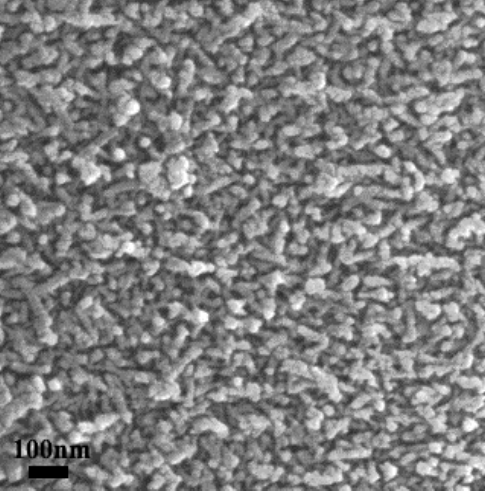
Figure 7. SEM image of the Pt 0.3 /CeO 2 catalyst after reaction for 130 h.